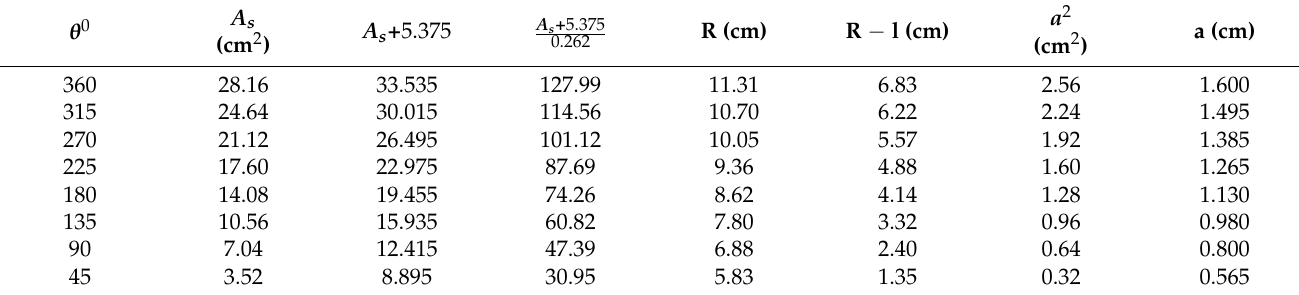
Figure 7. The entire unstructured centrifugal pump system for numerical simulation. Table 2. Internal cross-sectional area profile of volute